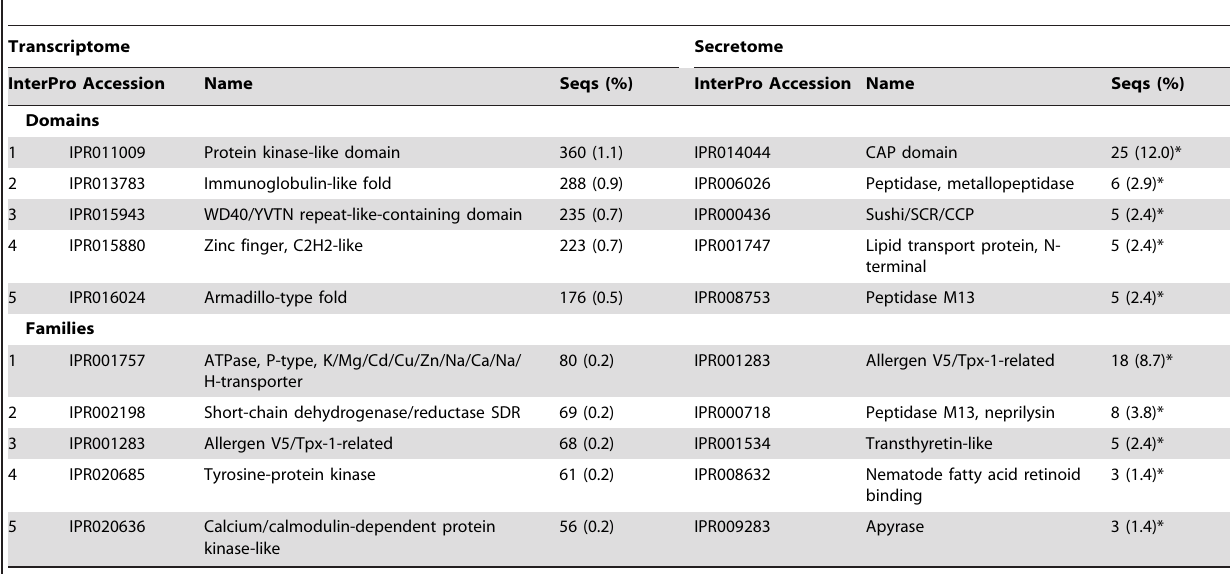
*Indicates enrichment of the domain or the family in the ESP subset when compared to the transcriptome dataset (FDR , 0.5).